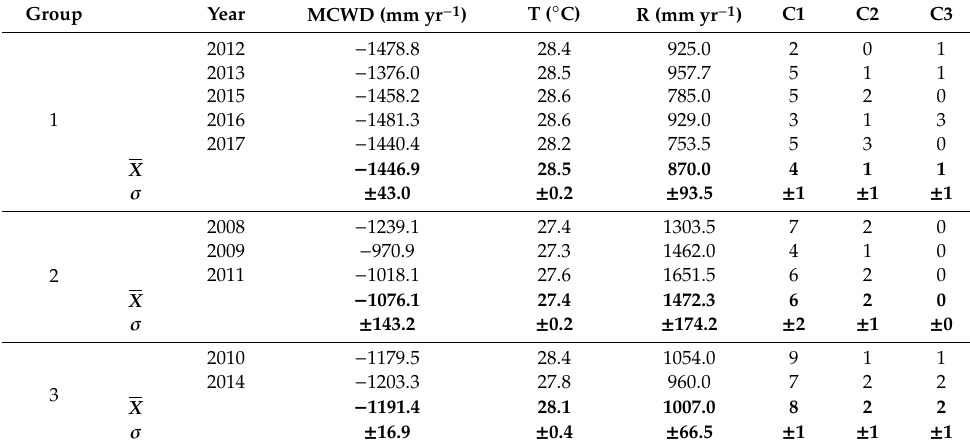
Table 1. Mean values and standard deviations of the climate variables for each group formed, for the district of Iguatu, Ceará, Brazil.